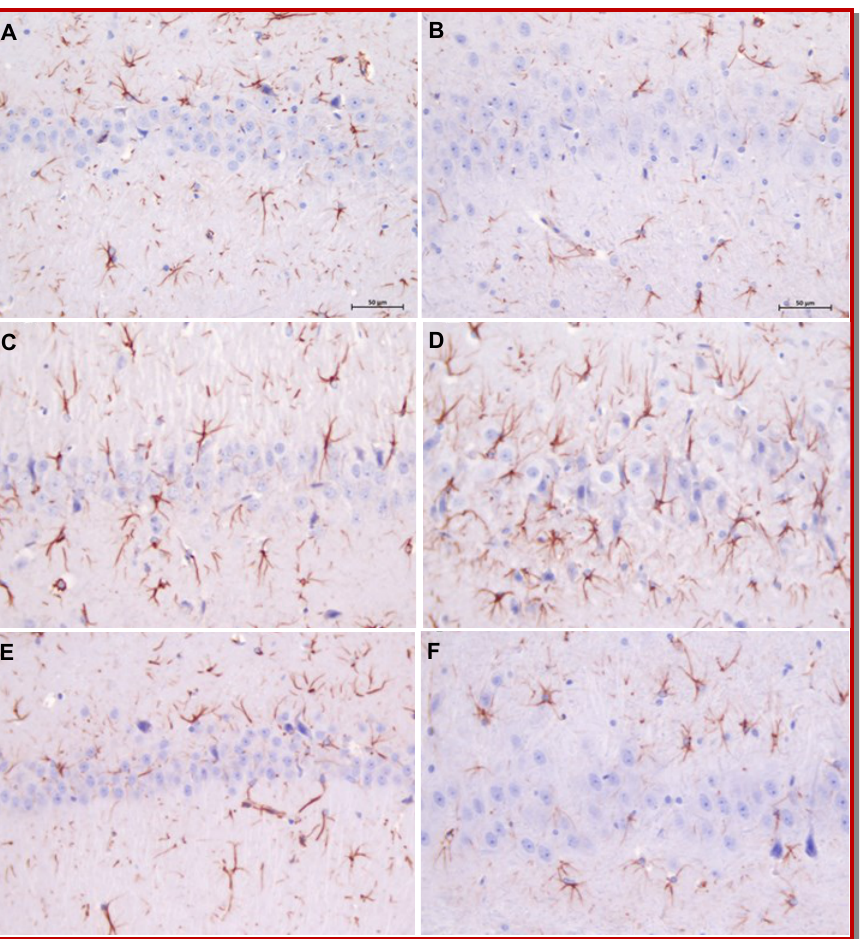
Figure 2: Microscopic view of glial fibrillar acidic protein stained CA1 and CA3 regions of hippocampus. Astrogliosis was charac- terized by glial fibrillar acidic protein immunostaining. Normal control group male rats CA1 and CA3 (A-B); propionic acid and saline group male rats have increased astroglial activity CA1 and CA3 (C-D); propionic acid and medroxyprogesterone group male rats have decreased astroglial activity CA1 and CA3 (scale bars = 50 μ m)